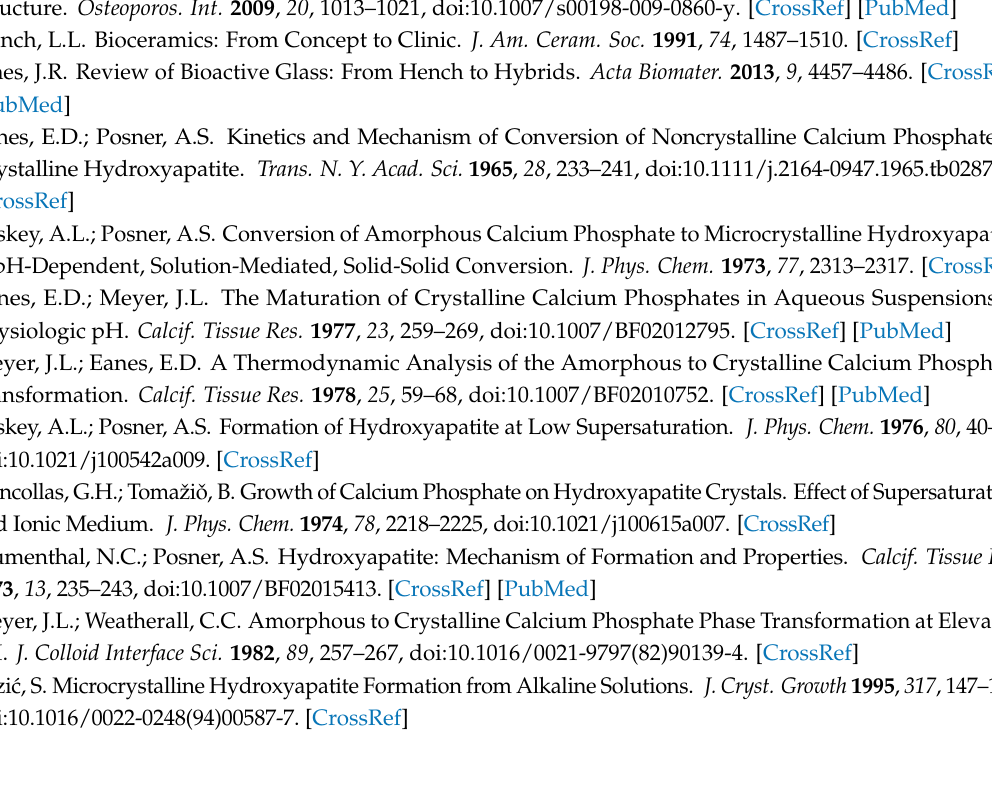
Figure S1: FTIR spectra shown across the full spectral range